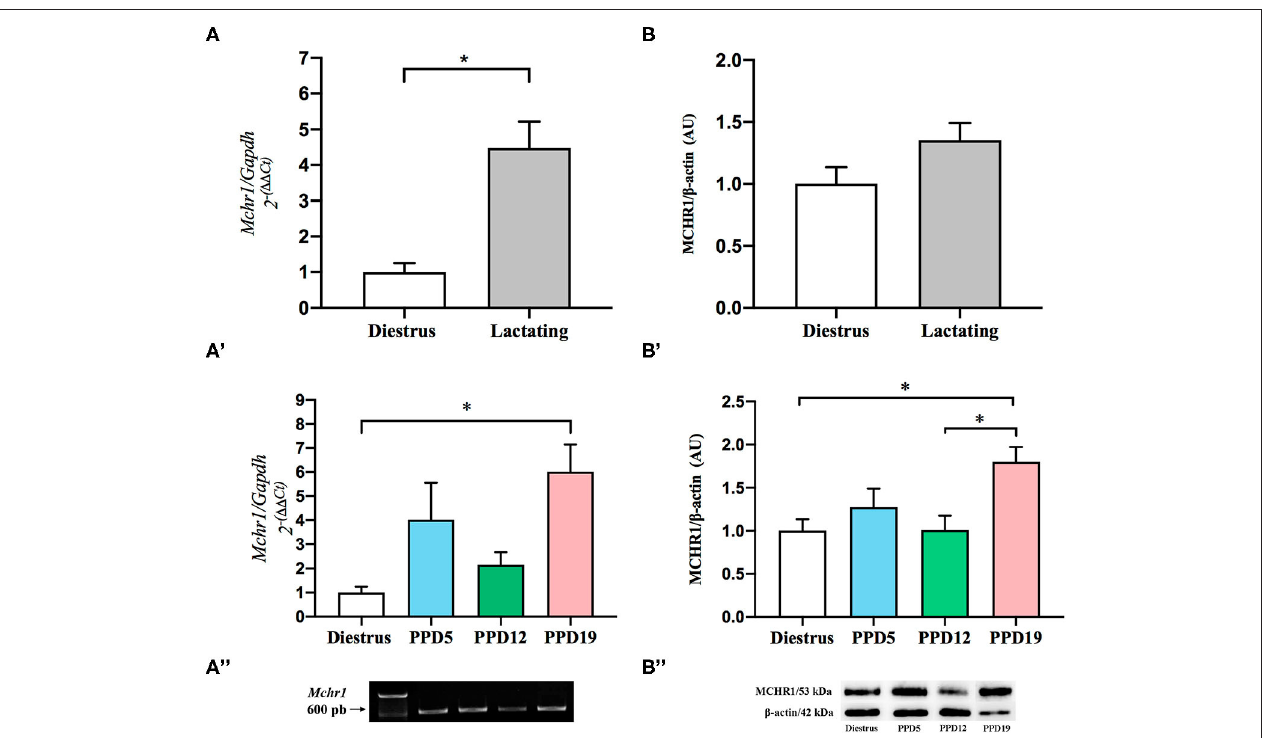
FIGURE 2 | Effect of the lactation in the expression of mRNA Mchr1 and MCHR1 protein content in the rat mammary gland. (A) Significant effect of lactation in the Mchr1 expression in mammary gland of the lactating group when compared to the diestrus, U = 423, * p = 0.0002, Mann–Whitney. (A’) Dunn’s post-hoc analysis indicates differences between diestrus and PPD19, K = 19.37, * p = 0.0002, Kruskal–Wallis. (A”) Analysis of PCR products by agarose gel electrophoresis revealed the presence of Mchr1 (639 bp) for mammary gland for all samples analyzed. Data are expressed as mean ± S.E.M. Diestrus ( n = 8), PPD5 ( n = 6), PPD12 ( n = 5), PPD19 ( n = 8). Relative Mchr1 expression data were normalized using Gapdh as housekeeping gene. The final data presented in the graphics were normalized according to the diestrus value. (B) There was no significant difference in the MCHR1 protein level in the mammary gland of diestrus and lactating rats ( p = 0.157), Student’s t -test. (B’) ANOVA revealed main group effect ( p = 0.027) for different phases of the lactation period, with MCHR1 protein level increases with the progression of lactation; * p = 0.027. Tukey post-hoc analysis indicates a significant increase in the MCHR1 protein in PPD19 as compared to diestrus or PPD12 (* p = 0.027). (B”) Analysis of bands by SDS-Page in 15% acrylamide revealed the presence of MCHR1 (53 kDa) for mammary gland and the integrity with the presence of β -actin (42 kDa). Data are expressed as mean ± S.E.M. Diestrus ( n = 5), PPD5 ( n = 5), PPD12 ( n = 4), PPD19 ( n = 4). Relative MCHR1 protein levels were normalized using β